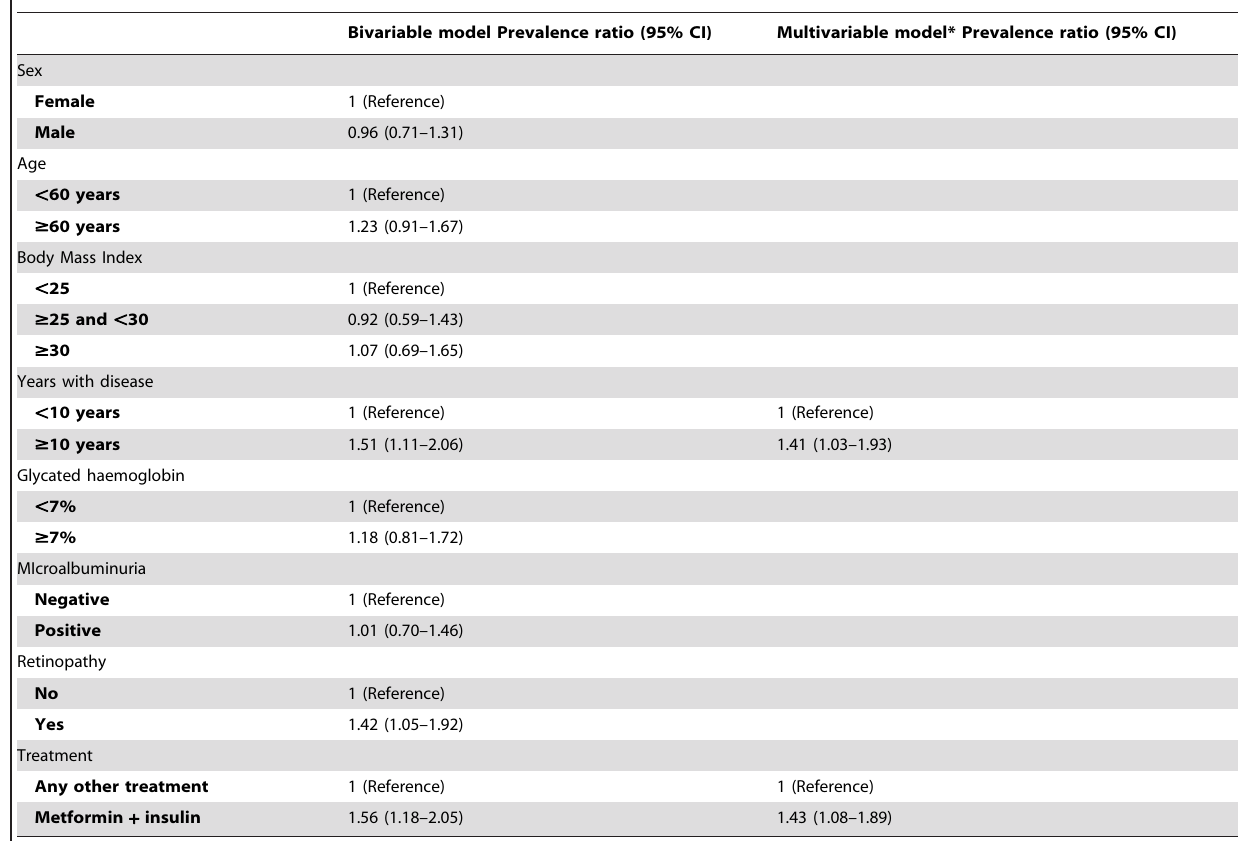
Table 3. Factors associated with Diabetic Peripheral